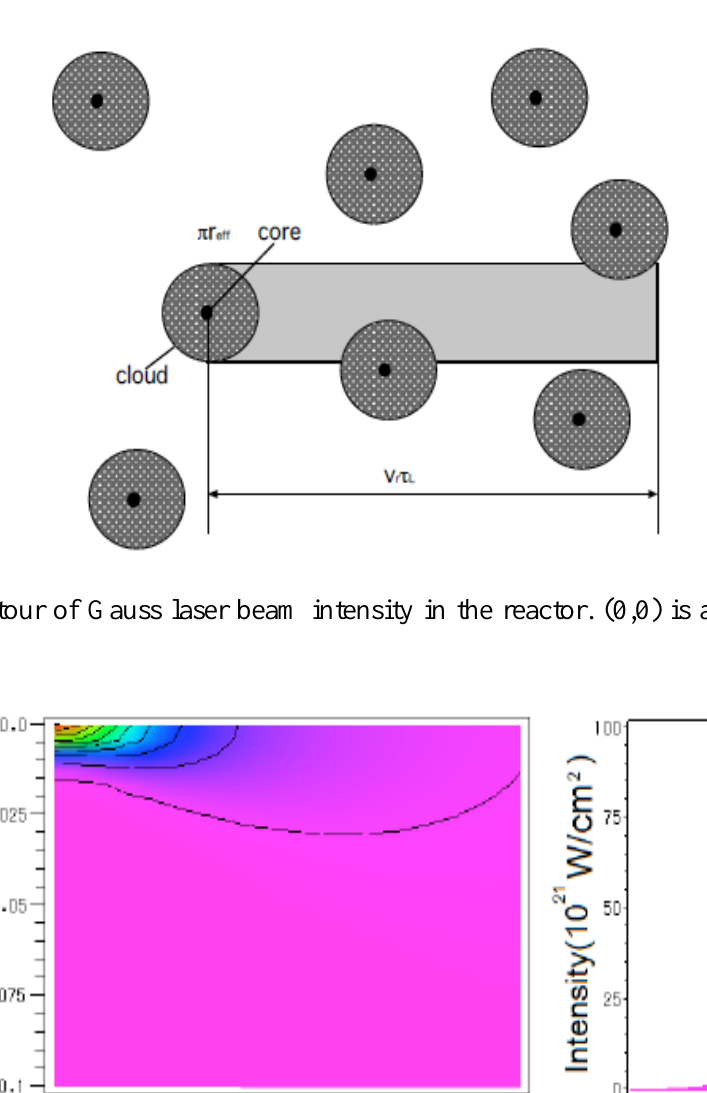
Figure 12. Model for nuclear reaction with a cloud around the nuclear core.